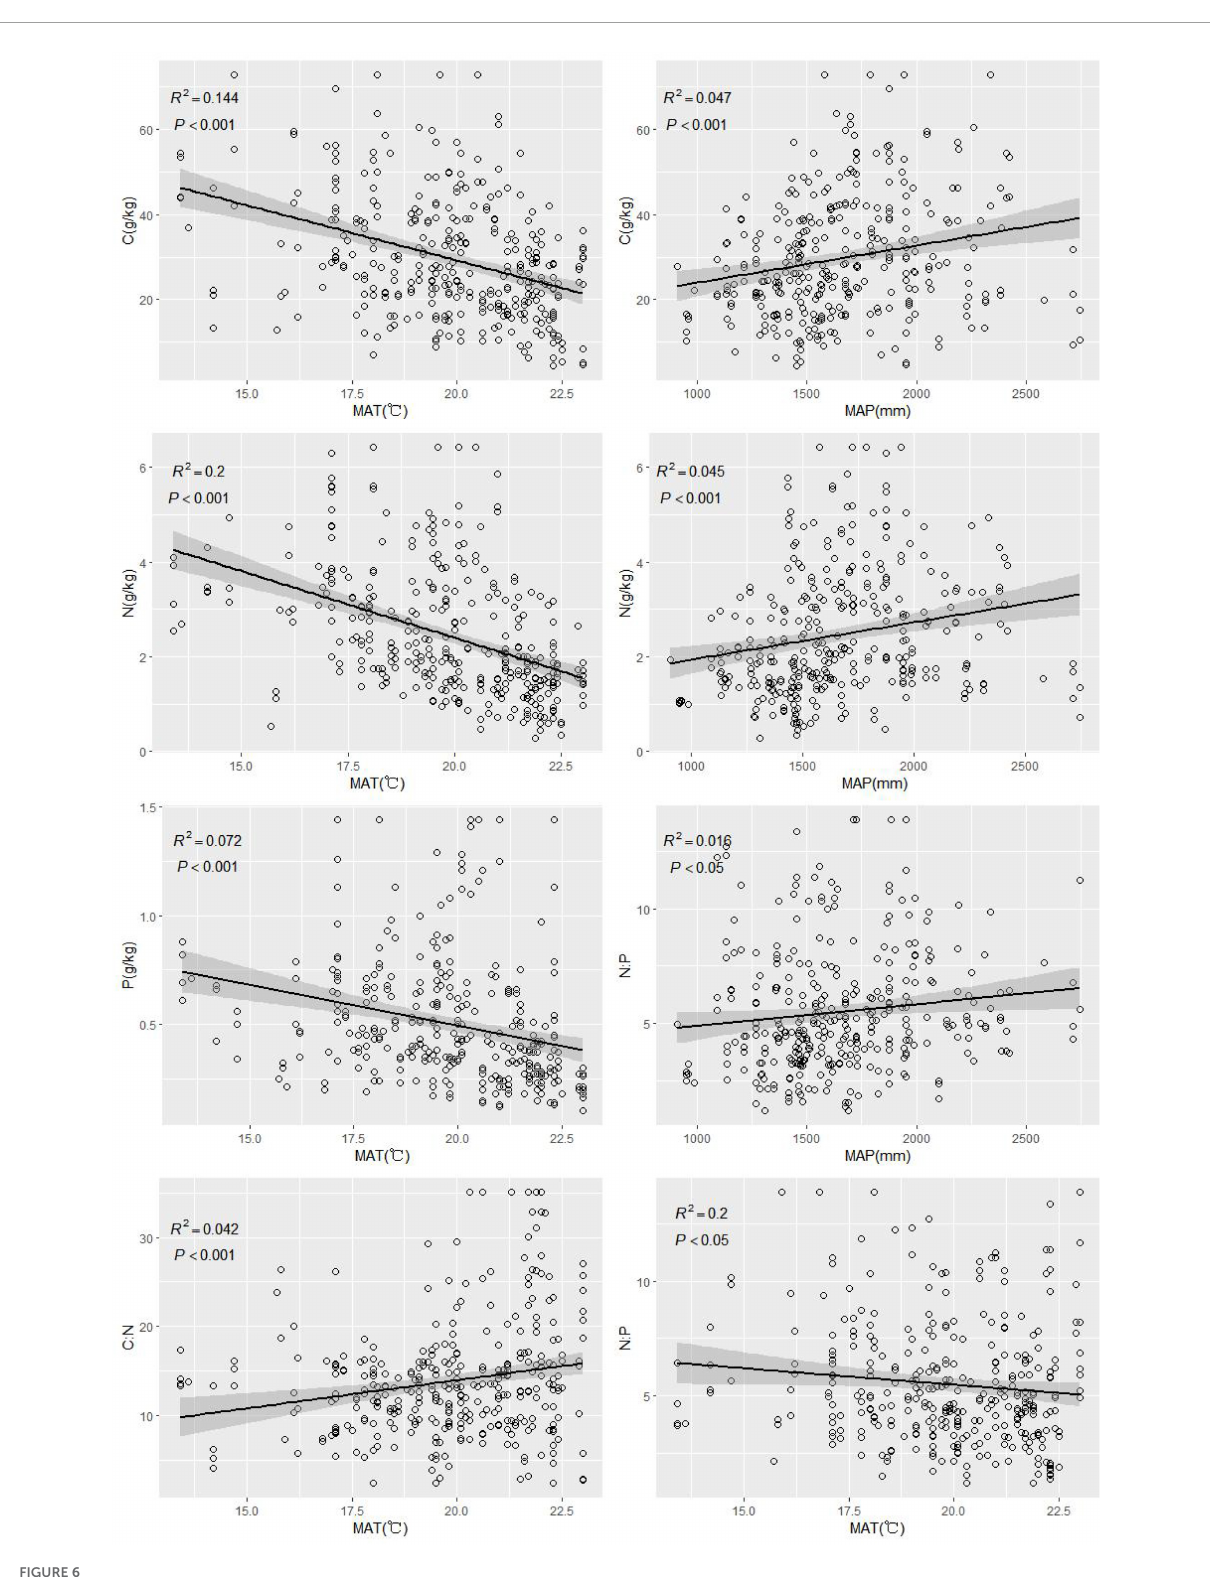
FIGURE6 Significant relationships between soil C, N, P, C:N, N:P and MAT, MAP.